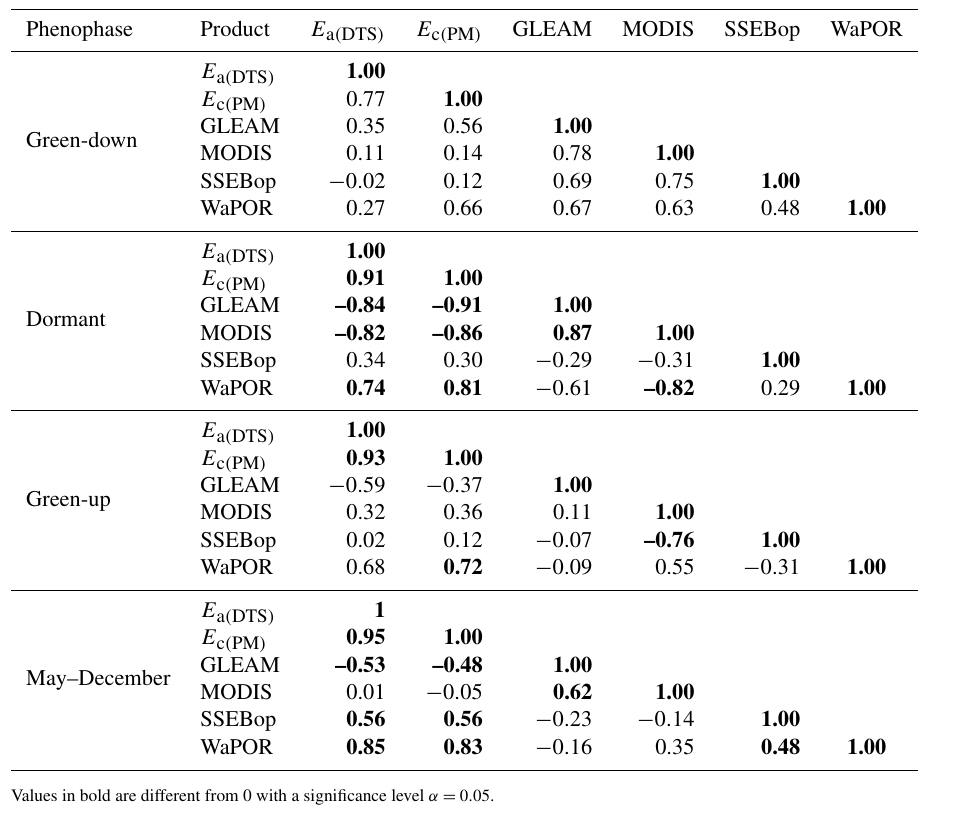
Table A4. Pearson r correlation coefficient of the comparison of evaporation products.